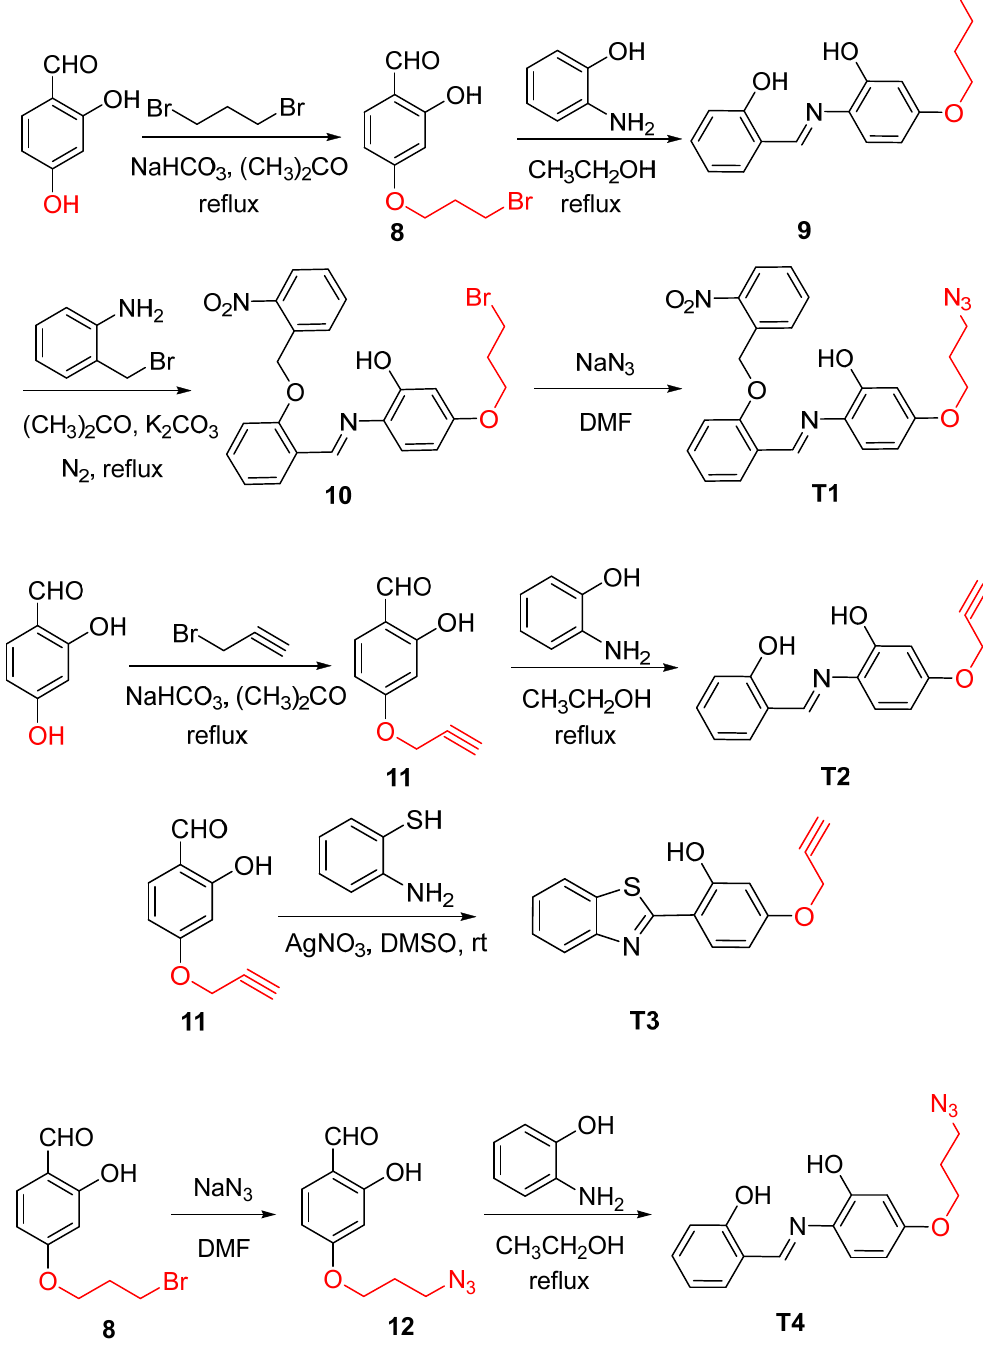
Figure 2. Synthesis routes of the probes T1 – T4 .